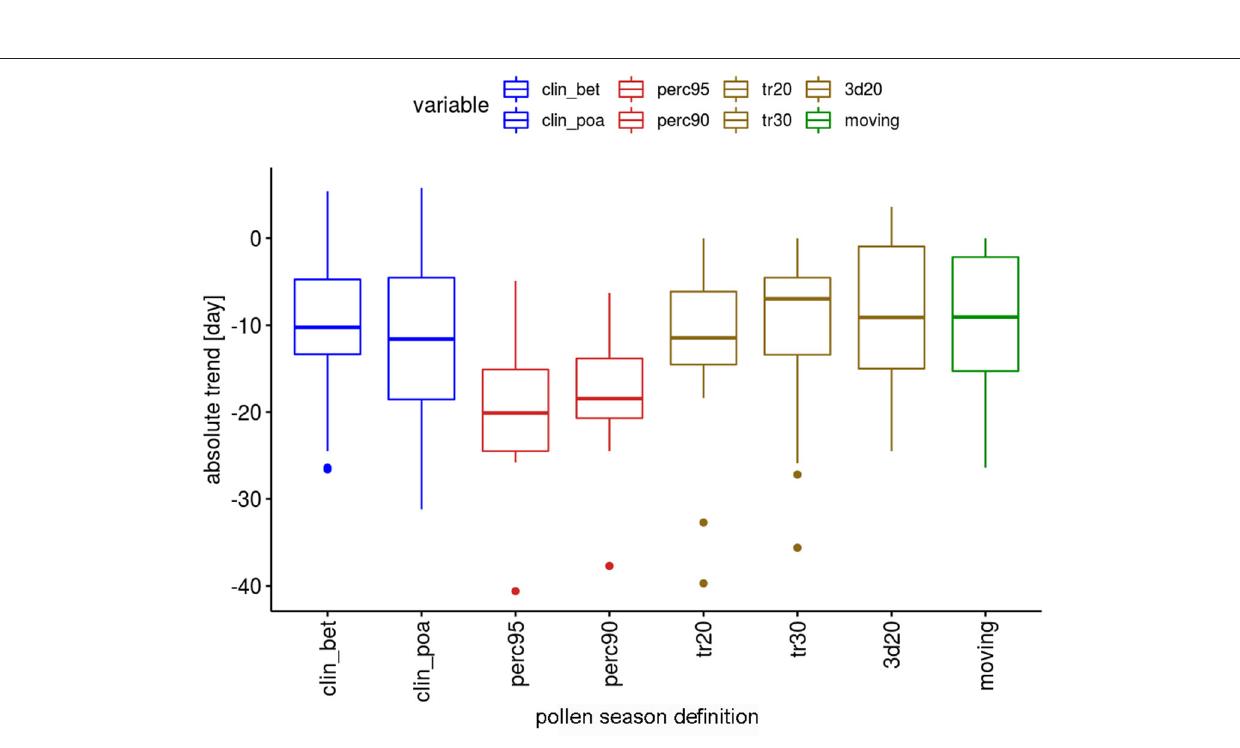
Frontiers in Allergy |